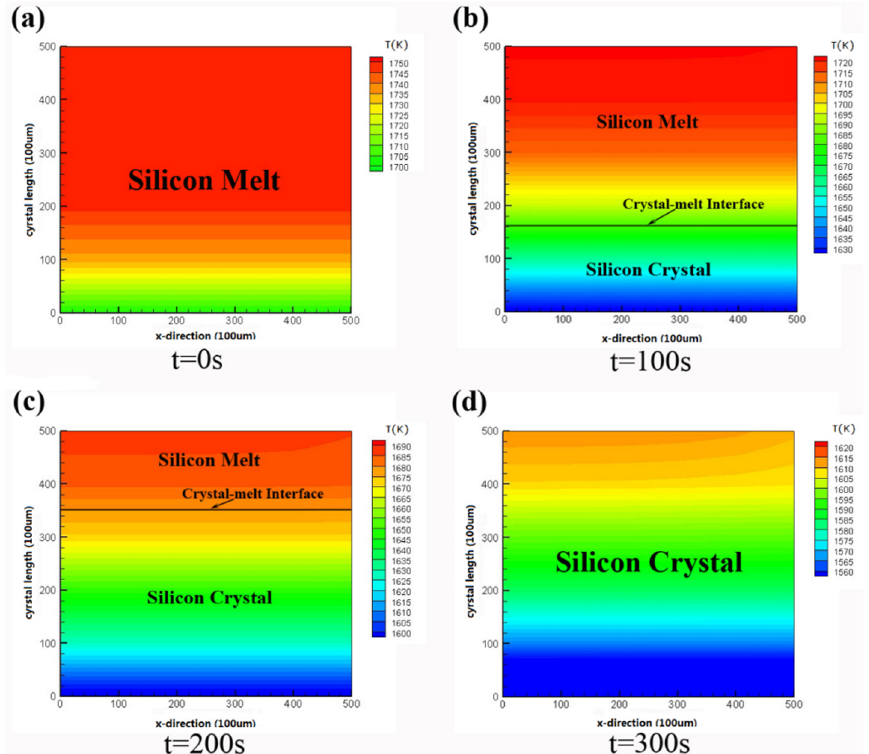
Figure 4. Temperature distribution and crystal-melt interface position with heat transfer coefficient of